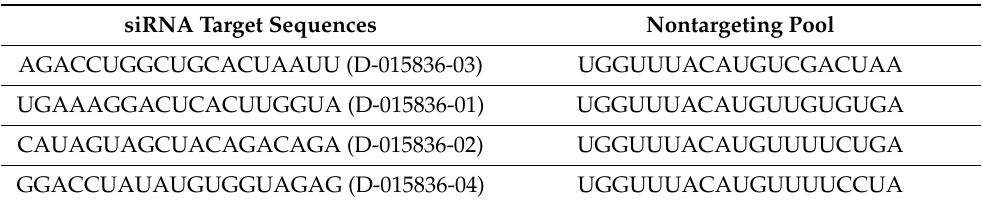
Table 1. CD274 siRNA SMARTpool target